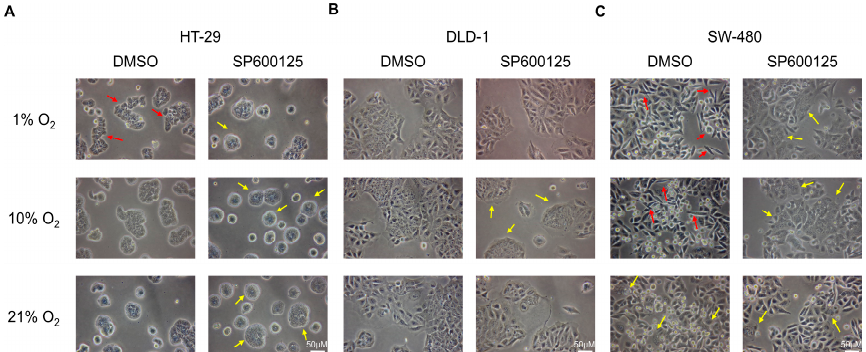
Figure 1. Cell morphological changes under different oxygen levels. HT-29 acquired more loosely packed colonies (red arrows) under 1% O 2 conditions, while the presence of SP600125 (10 µM) changed the cell colony to be more rounded and more densely packed (yellow arrows) under all oxygen levels investigated ( A ) DLD-1 did not show prominent changes in cell morphology under different oxygen level incubation. Cell colonies became more closely packed in 10% O 2 conditions (yellow arrows) in the presence of SP600125 ( B ) SW-480 showed more mesenchymal features at 1% and 10% O 2 by having more spindle-shaped cells (red arrows). More epithelial cell colonies (yellow arrows) formed under different oxygen levels with SP600125 addition, especially in 1% and 10% O 2 conditions ( C ). Sample images from 5 independent experiments performed (200× magnification).